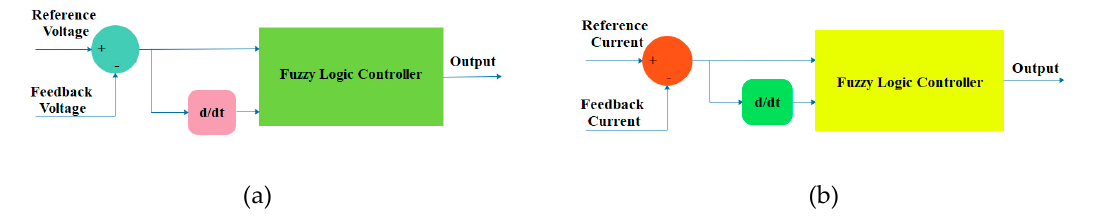
Figure 26. Proposed Fuzzy control block: ( a ) Voltage; ( b ) current control.